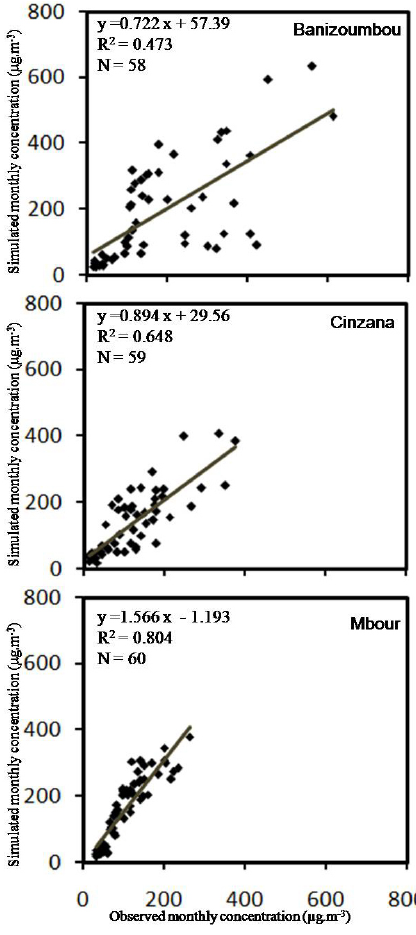
Figure 14. Scatter plot of monthly ALADIN dust surface concen- tration against observation over Banizoumbou, Cinzana and Mbour from 2006 to 2010. N is the number of averaged monthly surface concentration data available from 2006 to 2010. R is the correlation